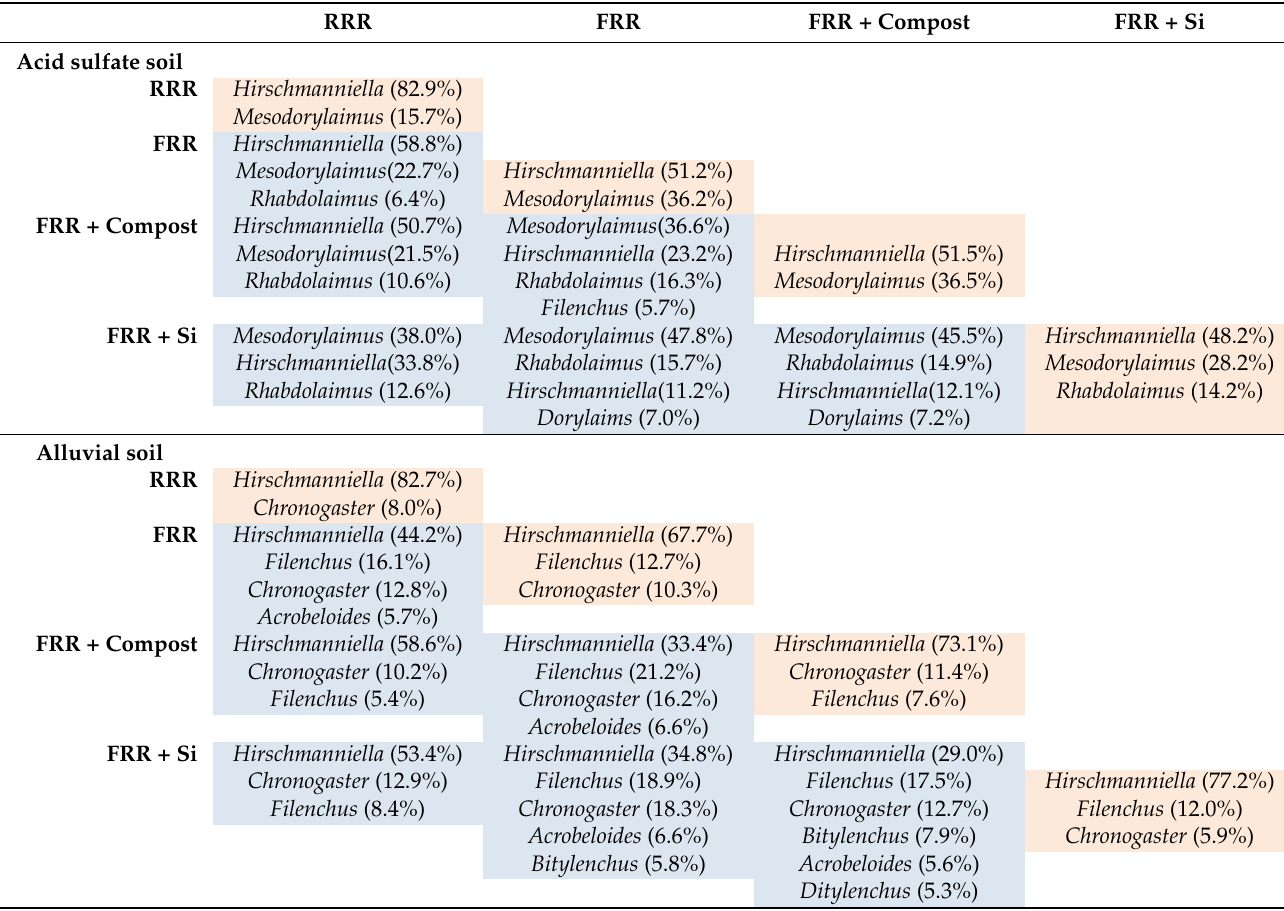
Pink boxes comparison of stations within treatment: average of similarity and genera that contributed most. Blue box indicates percentage of dissimilarity between treatments and genera that contributed most (cut-off percentage: